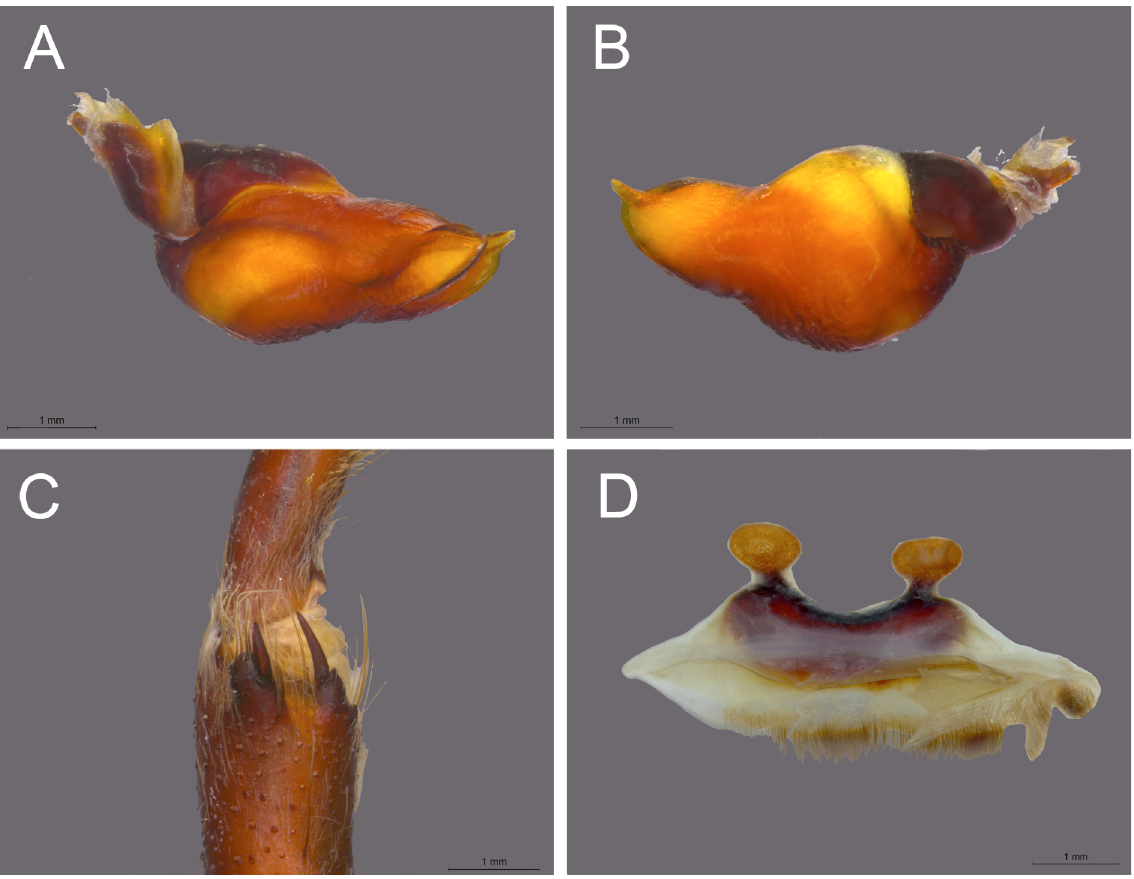
Fig. 11. Umbyquyra palmarum (Schiapelli & Gerschman, 1945) gen. et comb. nov. A–C . Holotype, ♂, Barão de Melgaço River, Rondônia, Brazil (MACN 832). A . Palp prolateral. B . Retrolateral. C . Tibial